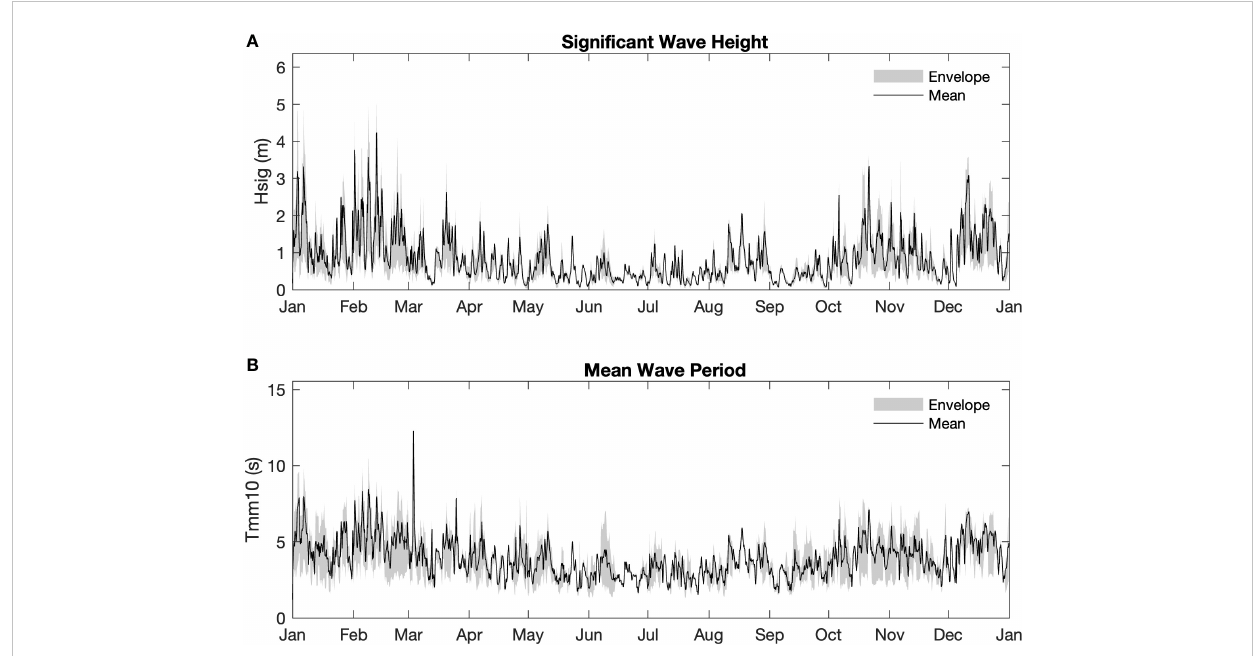
FIGURE 6 Simulated mean, minimum and maximum (A) signi fi cant wave height ( H s ) and (B) mean wave period ( T m ) across all sample locations during